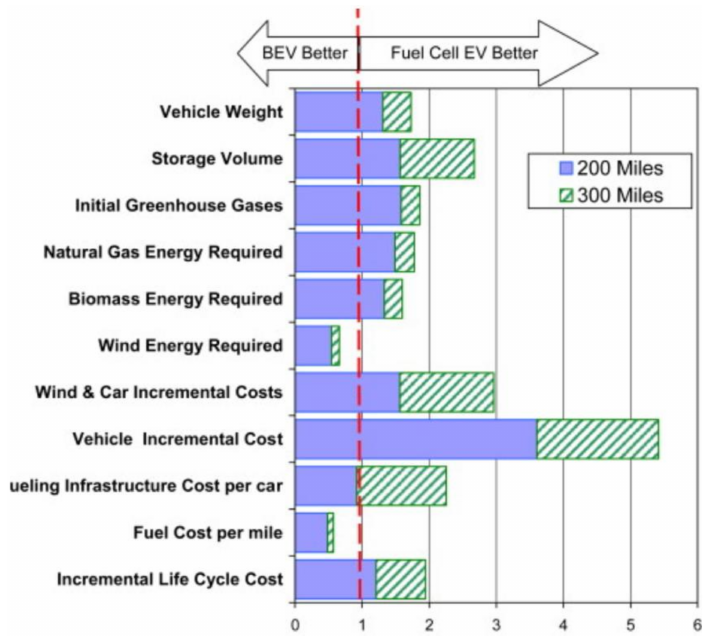
Figure 4. Comparison between Fuel cell and battery electric vehicle